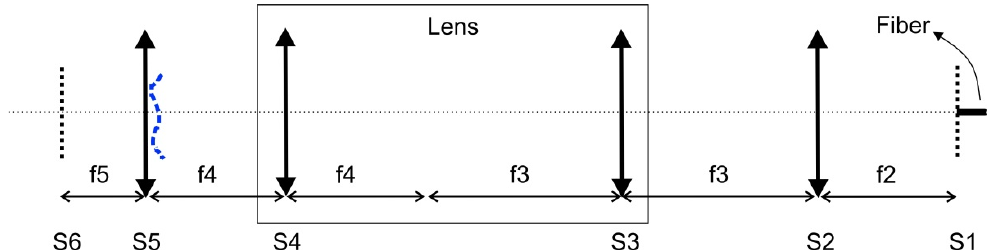
Figure 1. Optical scheme for the deformable mirror/Fresnel plate modeling. Radiation is emitted from the fiber in the center of the S1 plane. In the case of deformable mirror modeling, a combined phase mask (deformable mirror plus the lens with f2 focal length) is placed in the S2 plane. In the case of DLP modeling, a corresponding binary mask is placed in the S2 plane. The combination of lenses in the S3 and S4 planes transfers the field from the S2 to the S5 plane. A lens in the S5 plane focuses radiation in the S6 plane. Aberrations are inserted into the S5 plane (marked with a blue dotted line).